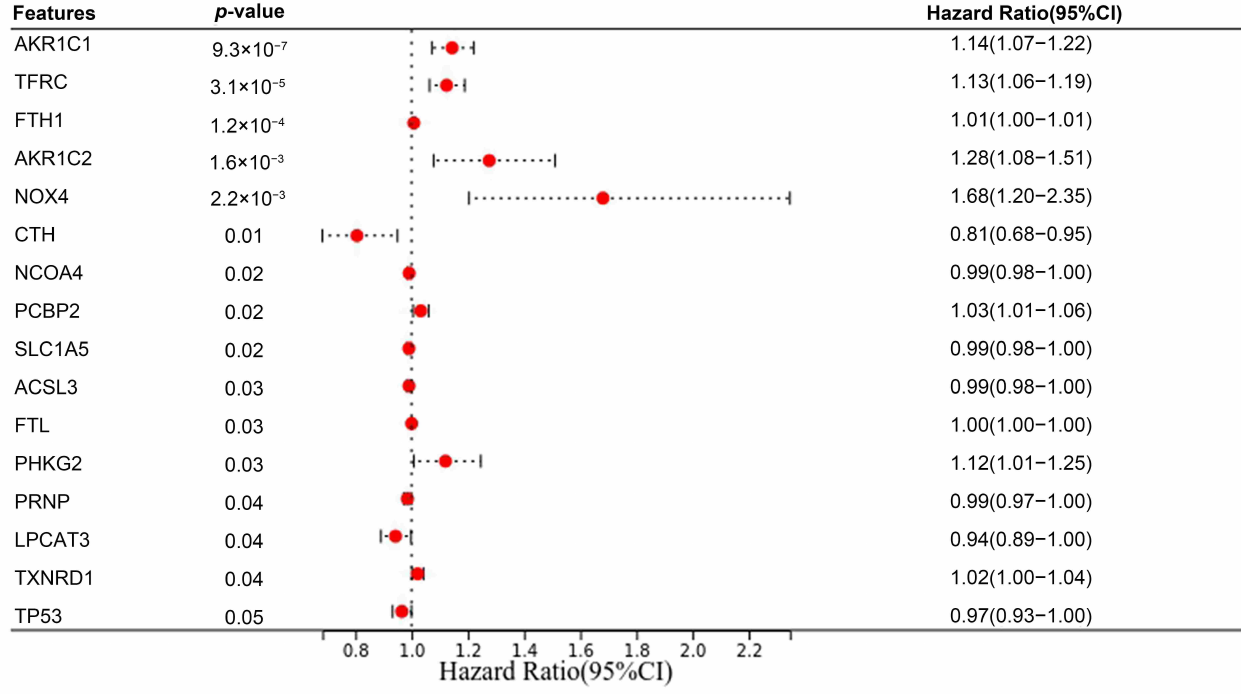
FIGURE 2. Univariate Cox regression analysis on 41